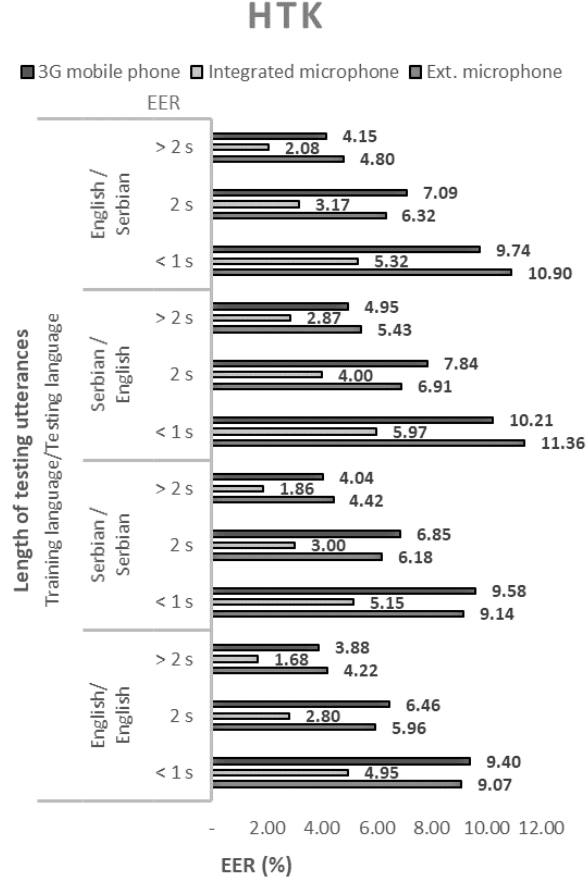
Figure 4. Equal error rates for the HTK speaker recognition model.